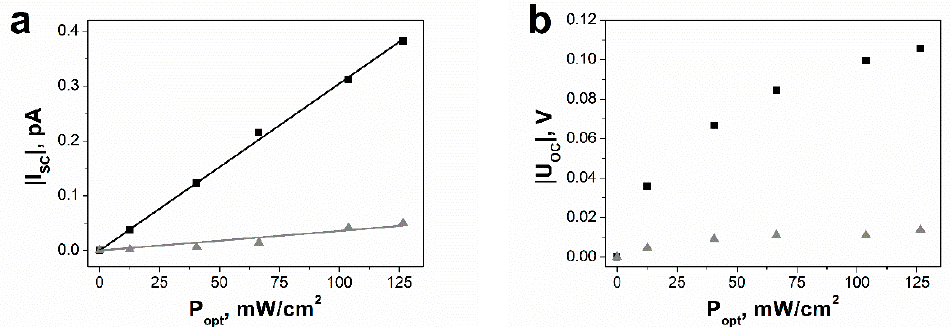
Figure 9. Influence of the optical power density on separated contributions to ( a ) I SC and ( b ) V OC from the switchable polarization ( ■ ) and unswitchable internal bias field ( ▲ ) in the SbSI FE-PV device ( λ = 488 nm; T = 268 K; p = 2 · 10 − 3 Pa; solid curves represent the best fitted dependences described by Equation (6); values of the fitted parameters are given in the text).